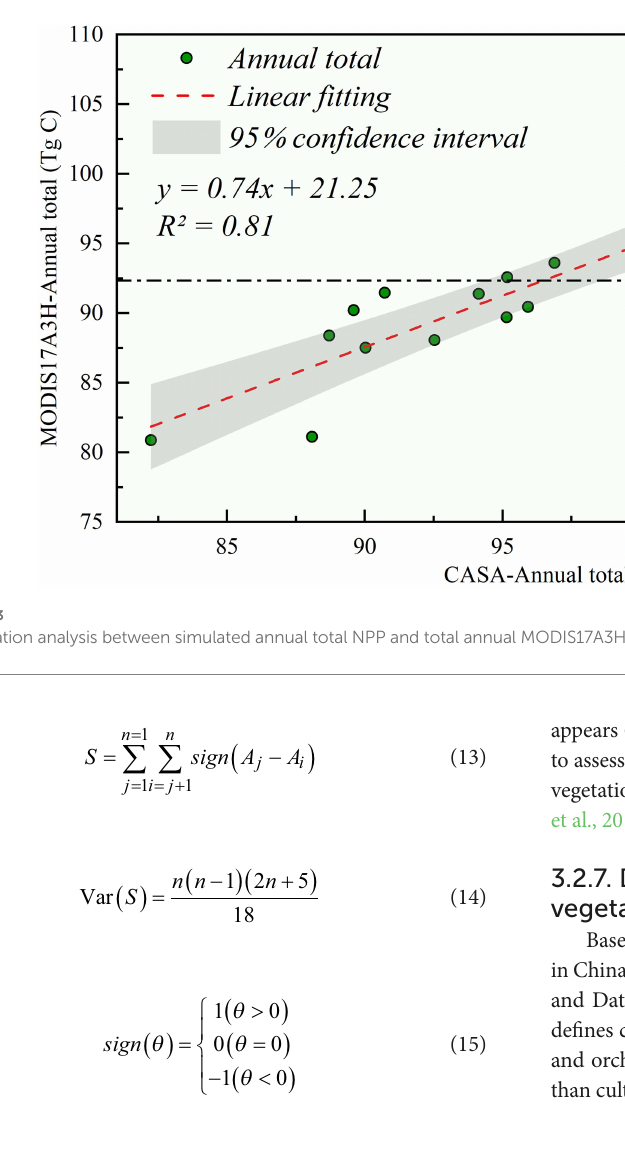
S is the test statistic; Z is the standardized test statistic; and n is the amount of data. NPP trends were classified into five categories according to the significance levels of Sen-MK trend analysis |Z| > 1.